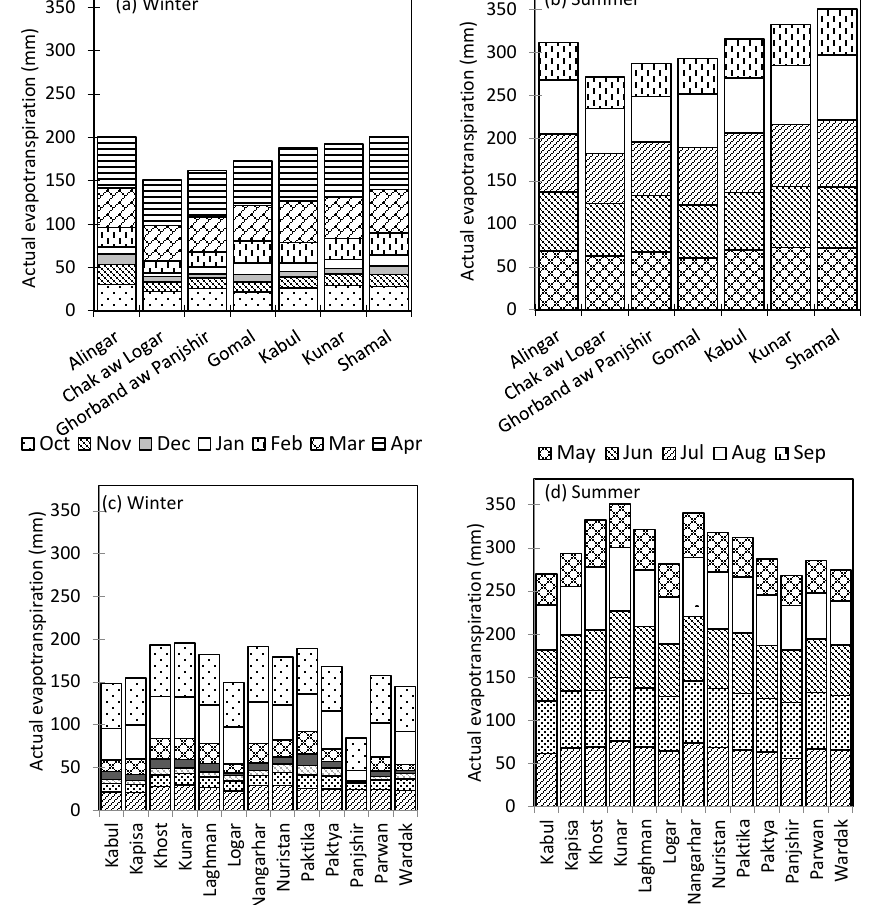
Figure 6. Mean seasonal (2003–2013) variation of actual evapotranspiration in winter and summer seasons at the ( a ) and ( b ) sub-basins and ( c ) and ( d ) provinces of the Kabul River Basin (Note: The statistical details have been explained in the text).